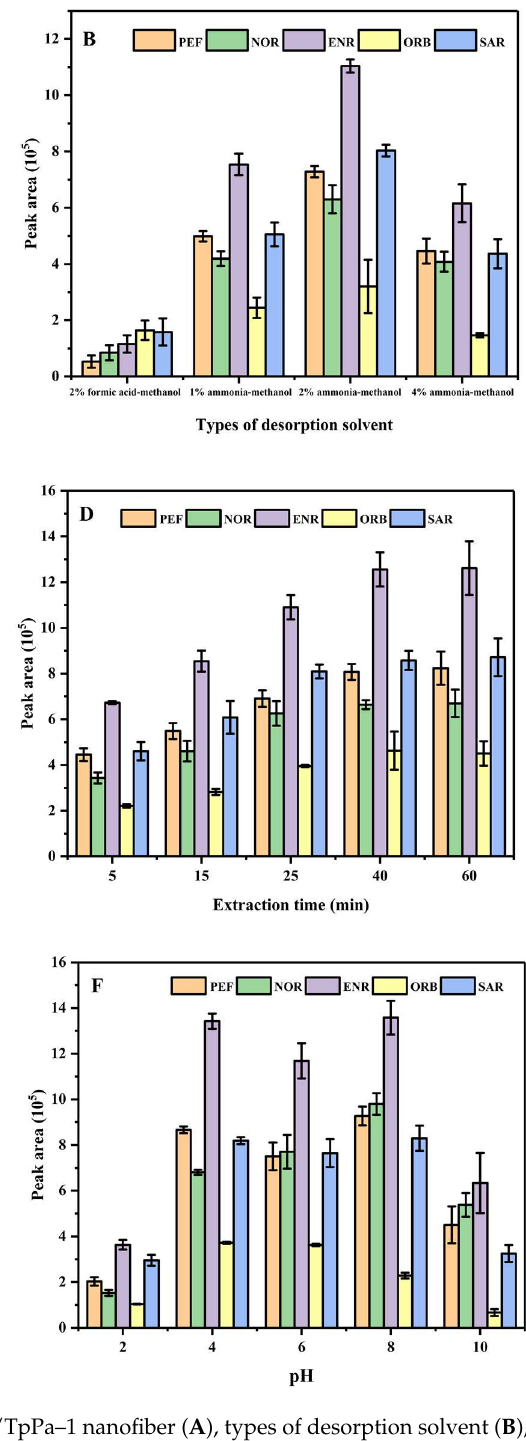
Figure 5. Effect of amount of PAN/TpPa–1 nanofiber ( A ), types of desorption solvent ( B ), desorption time ( C ), extraction time ( D ), concentration of NaCl ( E ), and standard solution pH value ( F ) on the extraction performance of QAs.